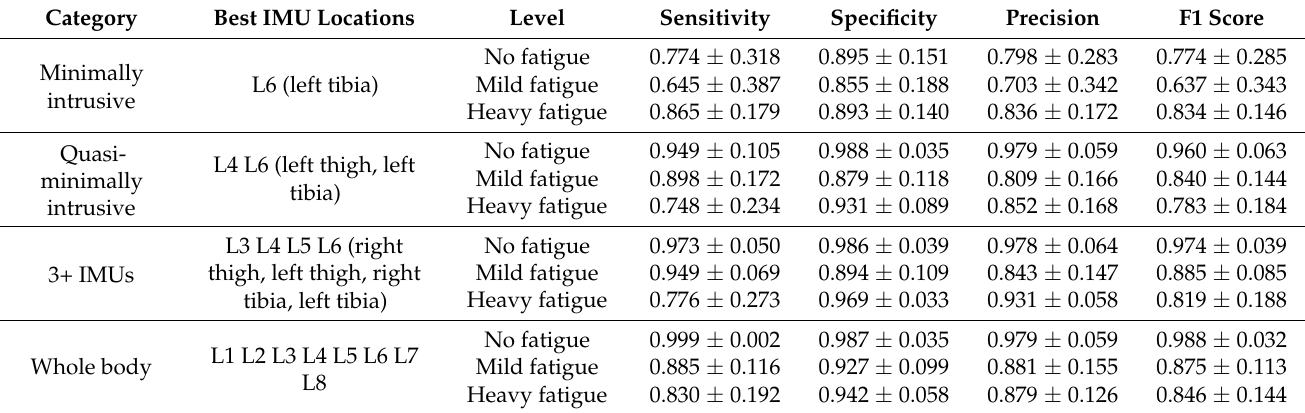
Table 5. Performance metrics for the three fatigue classes (Mean ± STD). Mean calculated over all datapoints from all